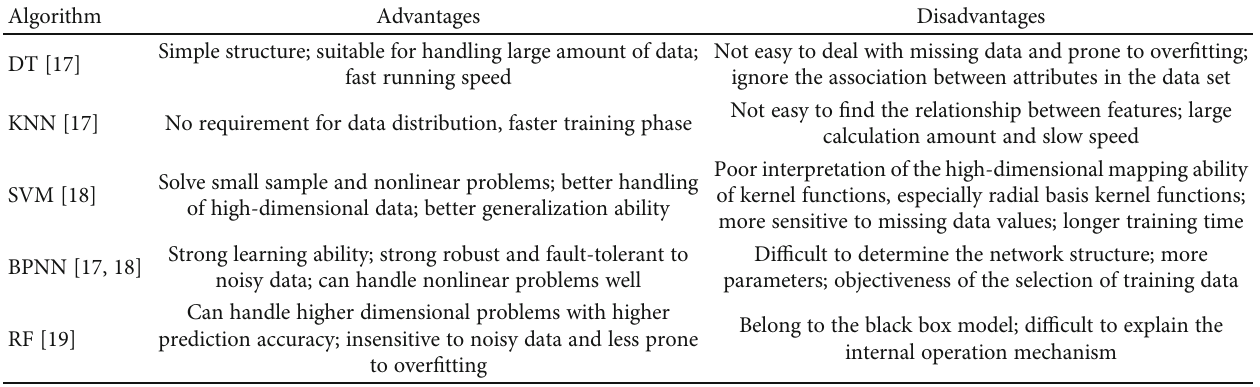
Table 1: Comparison of the advantages and disadvantages of machine learning algorithms.